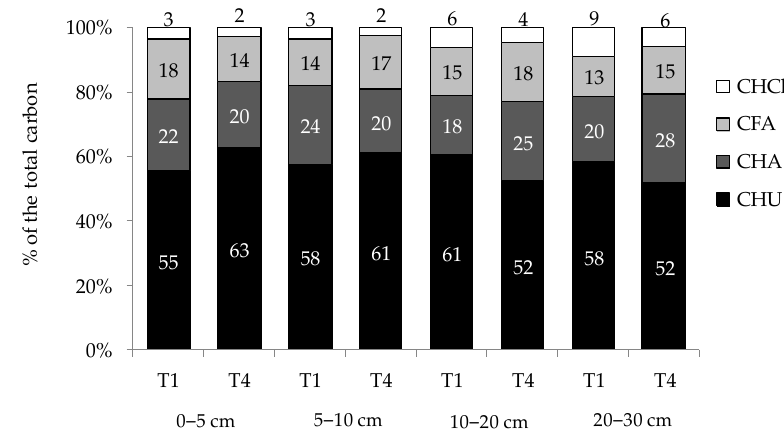
Figure 1. Contribution of C content in the acid extract (C HCl ), fulvic acid (C FA ), humic acid (C HA ), and humin (C HU ) fractions to the total carbon content of a Cambisol without charcoal (T1) and with charcoal −40 Mg ha −1 (T4) application.